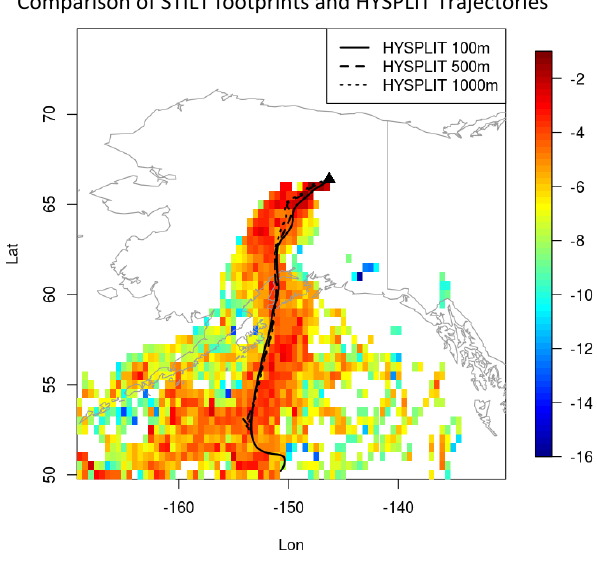
Figure 1. STILT footprints (shaded, units are ppmv/(micromolem − 2 s − 1 )) and HYSPLIT trajectories from receptors located at 100 (solid), 500 (dashed), and 1000m (dotted black lines) at 19:35UTC 20 August